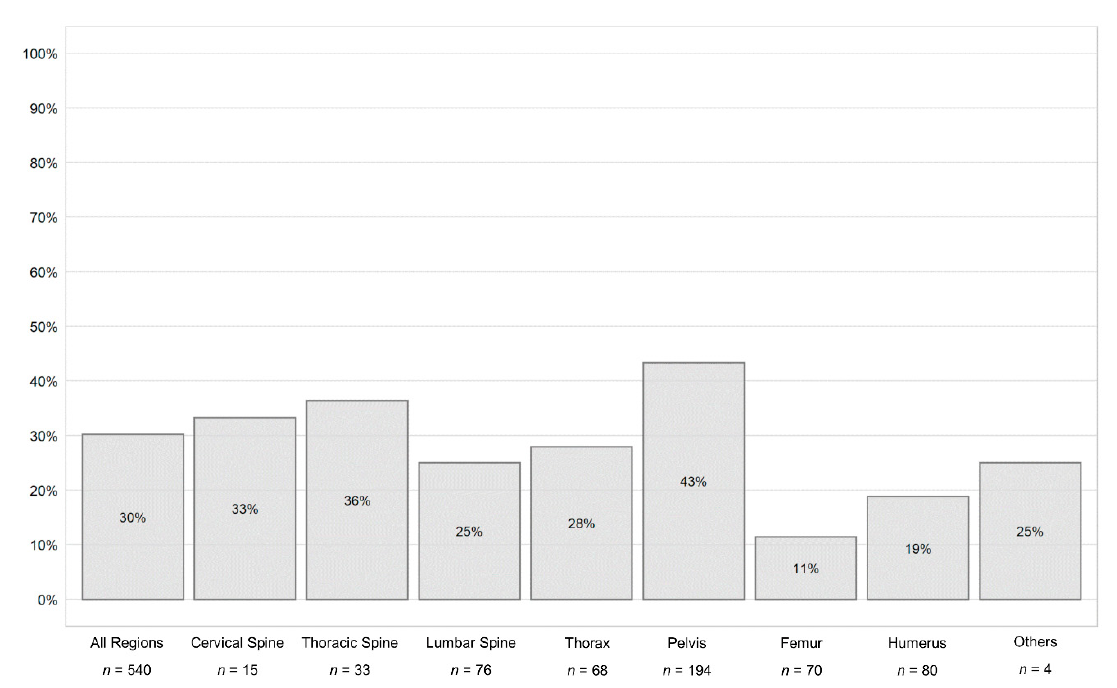
Figure 3. Cumulative percentage of diagnosis that would have been inaccurate if CT had not been performed in “XR before CT examination” ( n = 540 imaging processes) of the cervical spine, thoracic spine, lumbar spine, rib cage, pelvic ring, proximal femur and humerus, and other regions (clavicle, scapula, sternum, and coccyx).